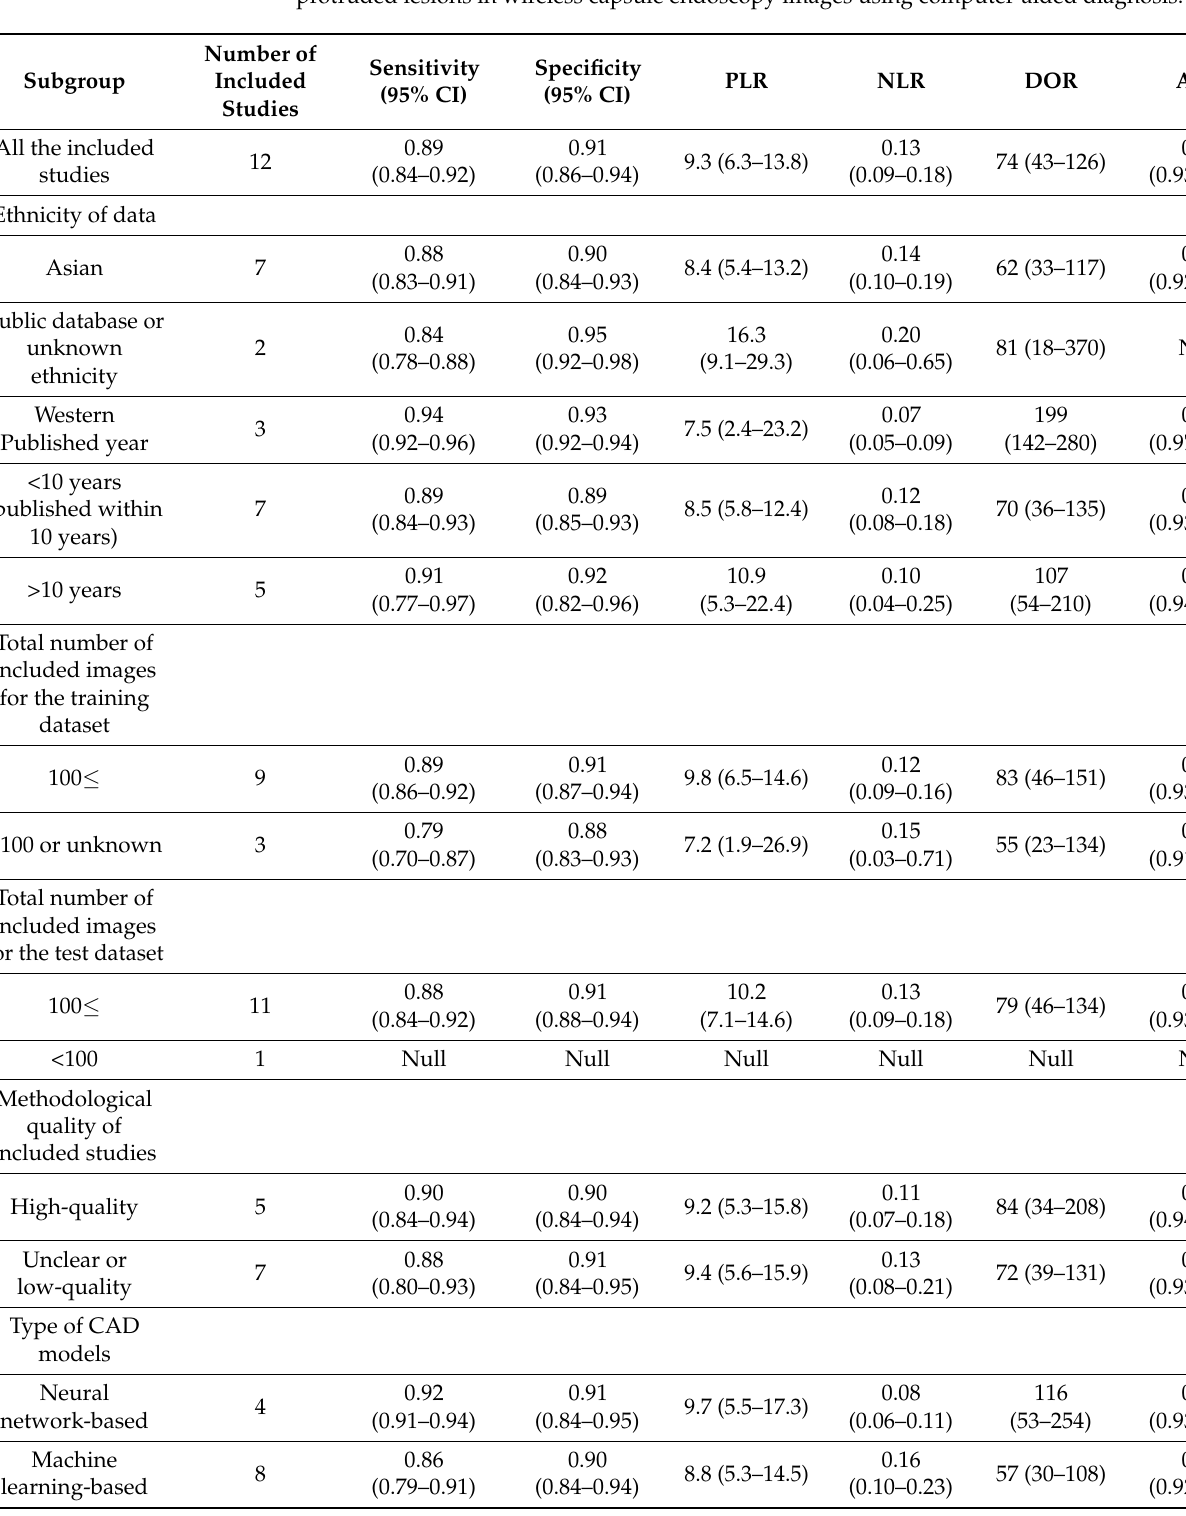
Table 3. Summary of performance and subgroup analysis of the included studies for the diagnosis of protruded lesions in wireless capsule endoscopy images using computer-aided